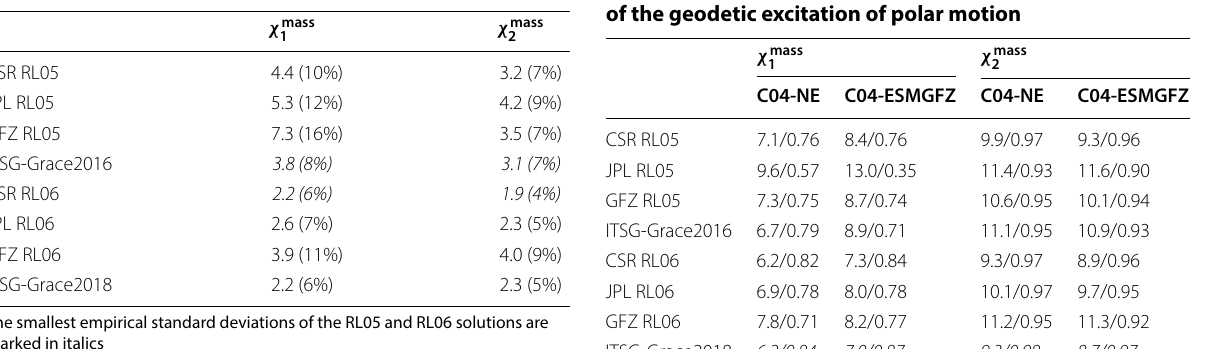
Table 3 RMS differences (mas)/correlation coefficients between the GRACE-based equatorial effective angular